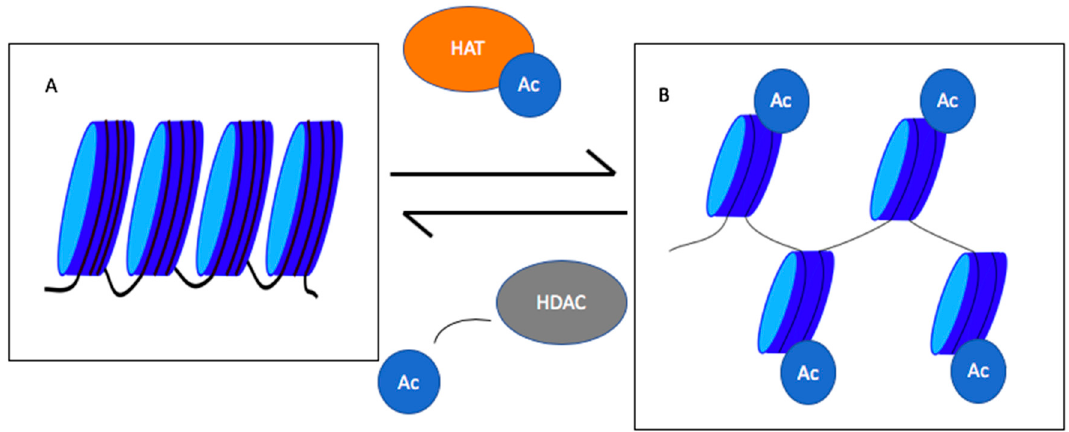
Figure 1. Roles of histone acetyl transferases (HATs) and histone deacetylase (HDACs) in chromatin condensation and decondensation. HATs add an acetyl group to histones decondensing chromatin, whereas HDACs remove acetyl groups leading to chromatin condensation. ( A ) represents the condensed chromatin, and ( B ) shows the decondensed chromatin. Ac = acetyl group [11].